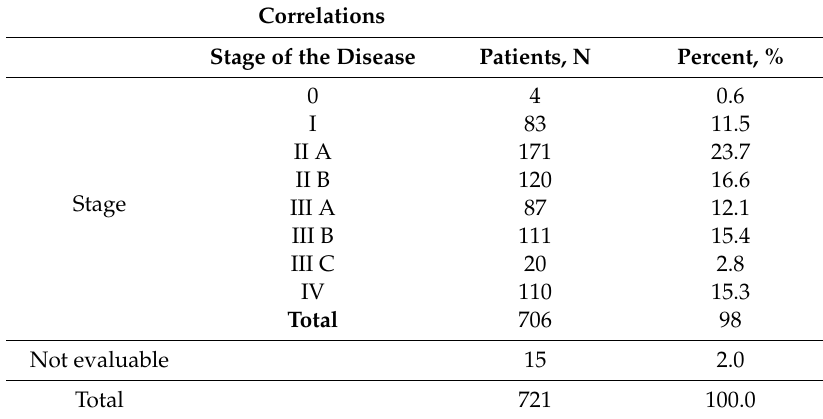
Table 6. Stage of the disease at